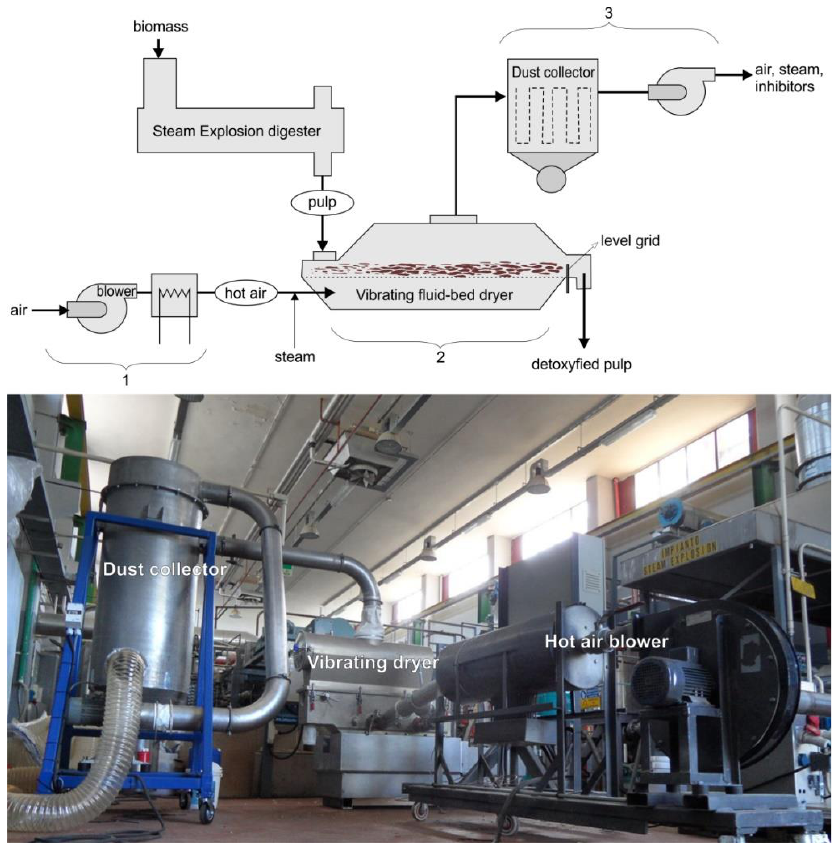
Figure 4. Scheme of the detoxification by the vibrating fluid-bed pilot-scale system. (1) Hot air blower; (2) Vibrating dryer; (3) Cyclone for powder abatement.